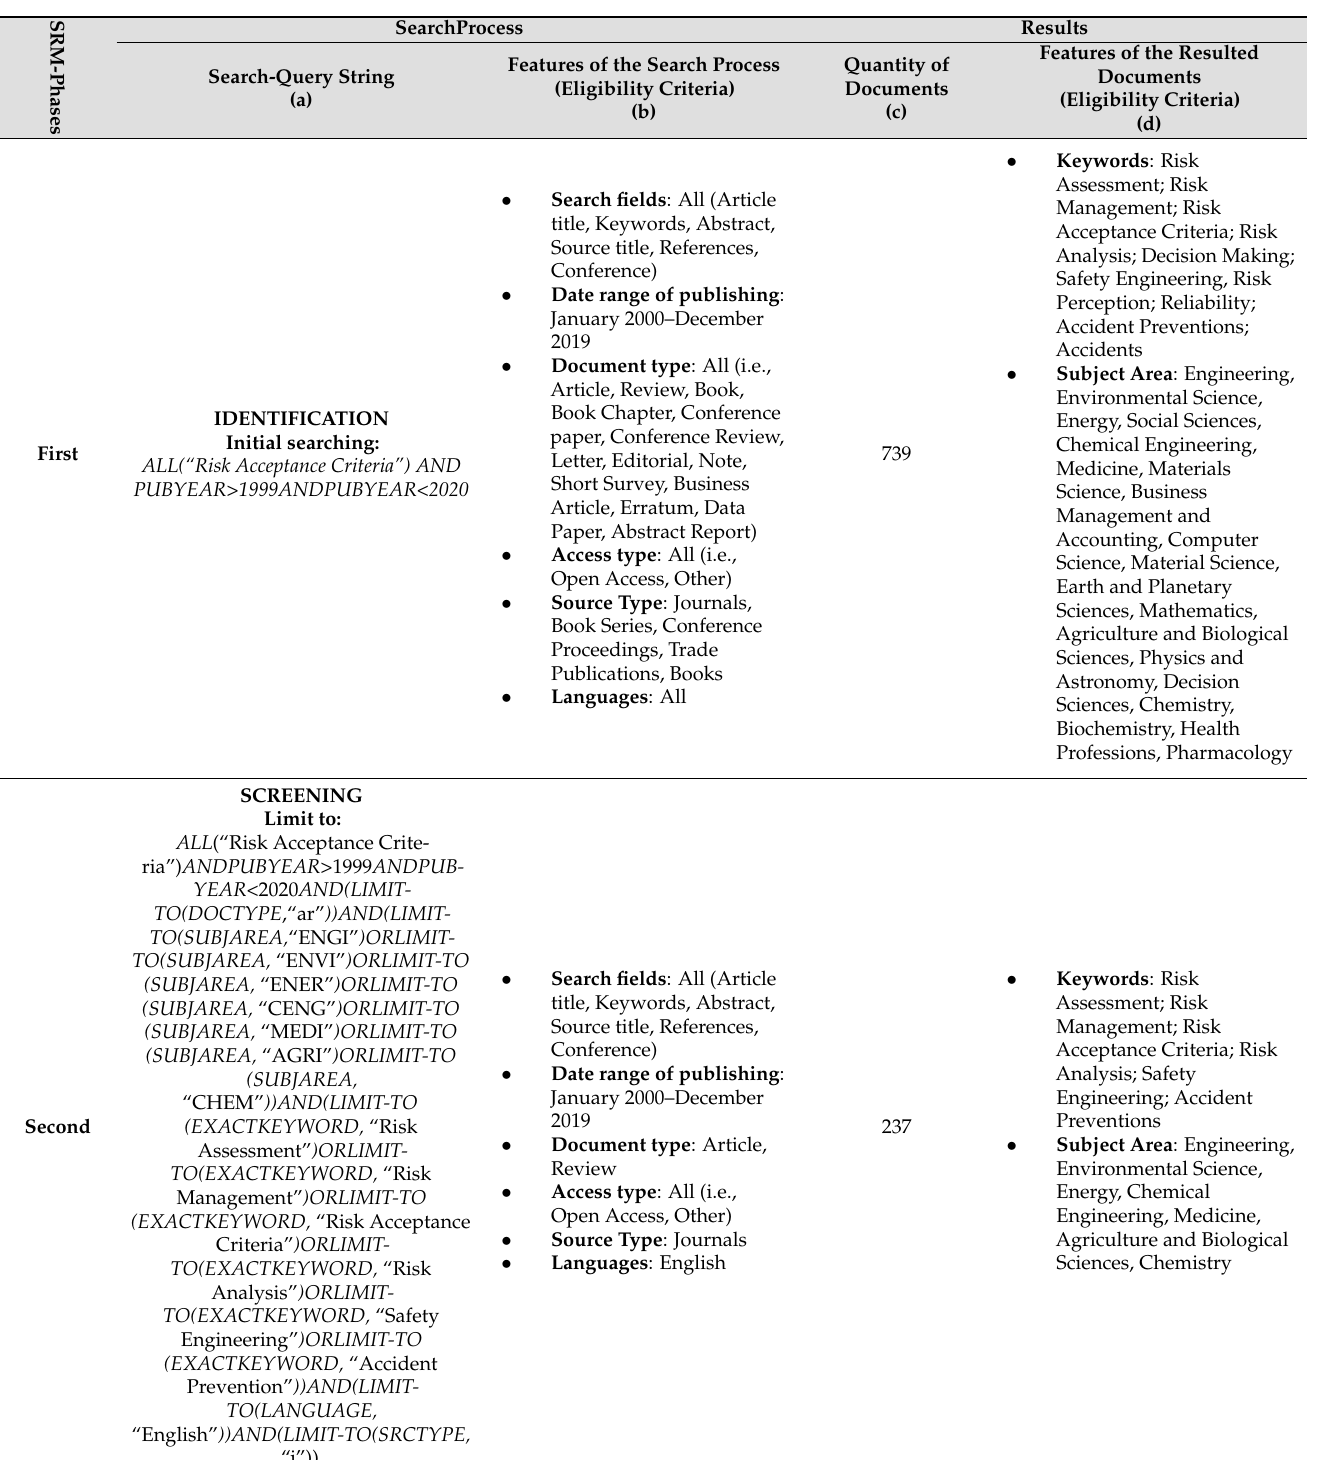
Table 4. Illustration of the SRM process. (a) Search-query string, (b) features of the search process, (c) the total quantity of documents, and (d) features of the resulted documents, as far as the RACs are concerned (in accordance with PRISMA- 2020